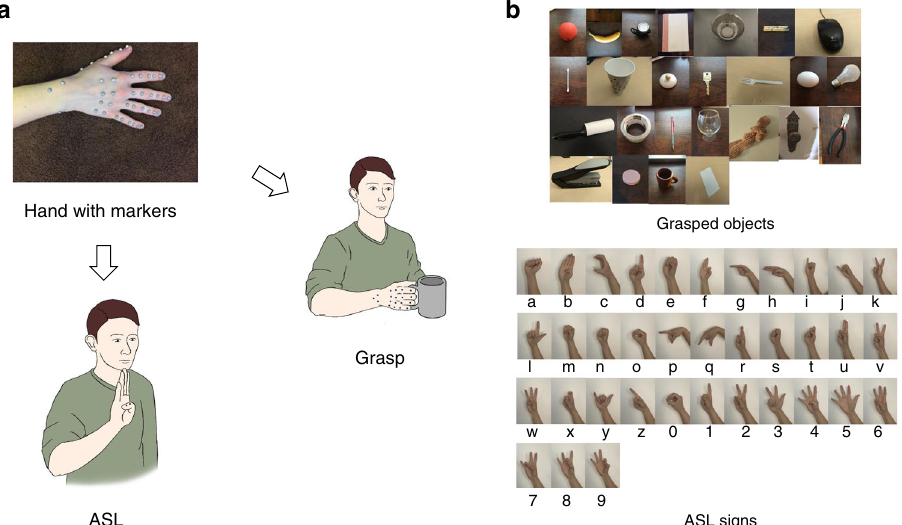
Fig. 1 Experimental design. a Subjects performed two manual tasks: grasping objects and signing in American Sign Language (ASL). Infrared cameras tracked the 3D trajectories of markers placed on the subjects ’ hand and joint angles were calculated from these marker trajectories using reverse kinematics. b Grasped objects and ASL